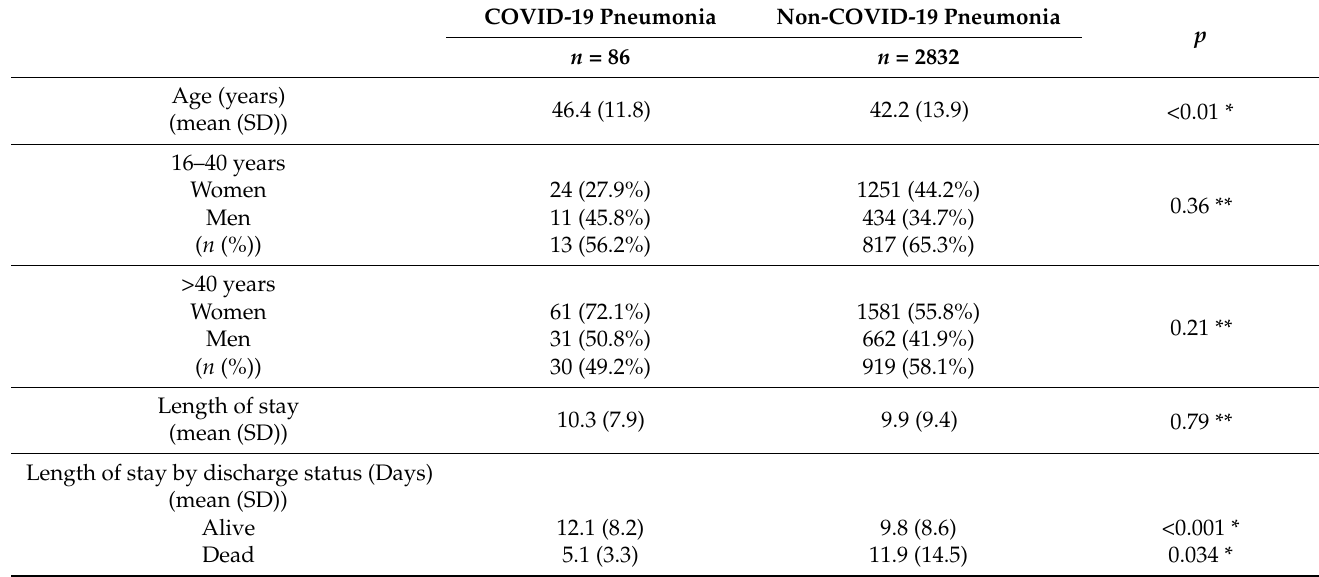
Table 1. General characteristics of Spanish DS patients older than 15 years admitted to the hospital due to COVID-19 or non-COVID-19